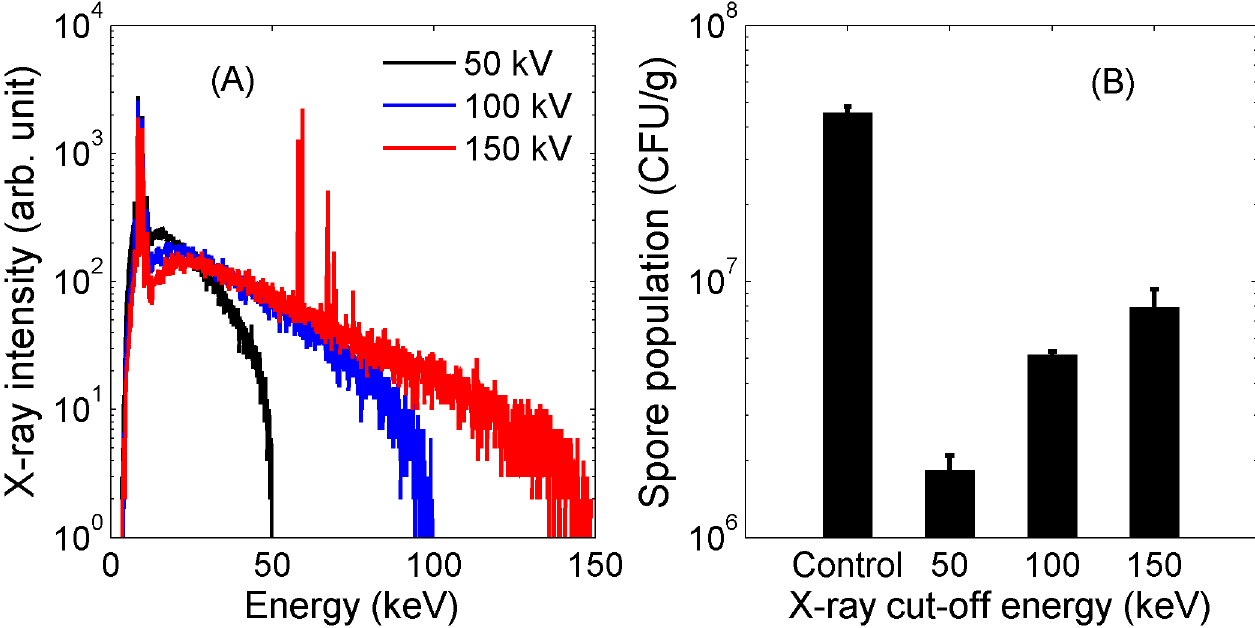
Fig 2. (A) SimulatedX-ray spectrum at different tube voltagesand (B) Inactivationof Bacilluspumilus spores under different X-ray spectrum (at a dose of 130 Gy).